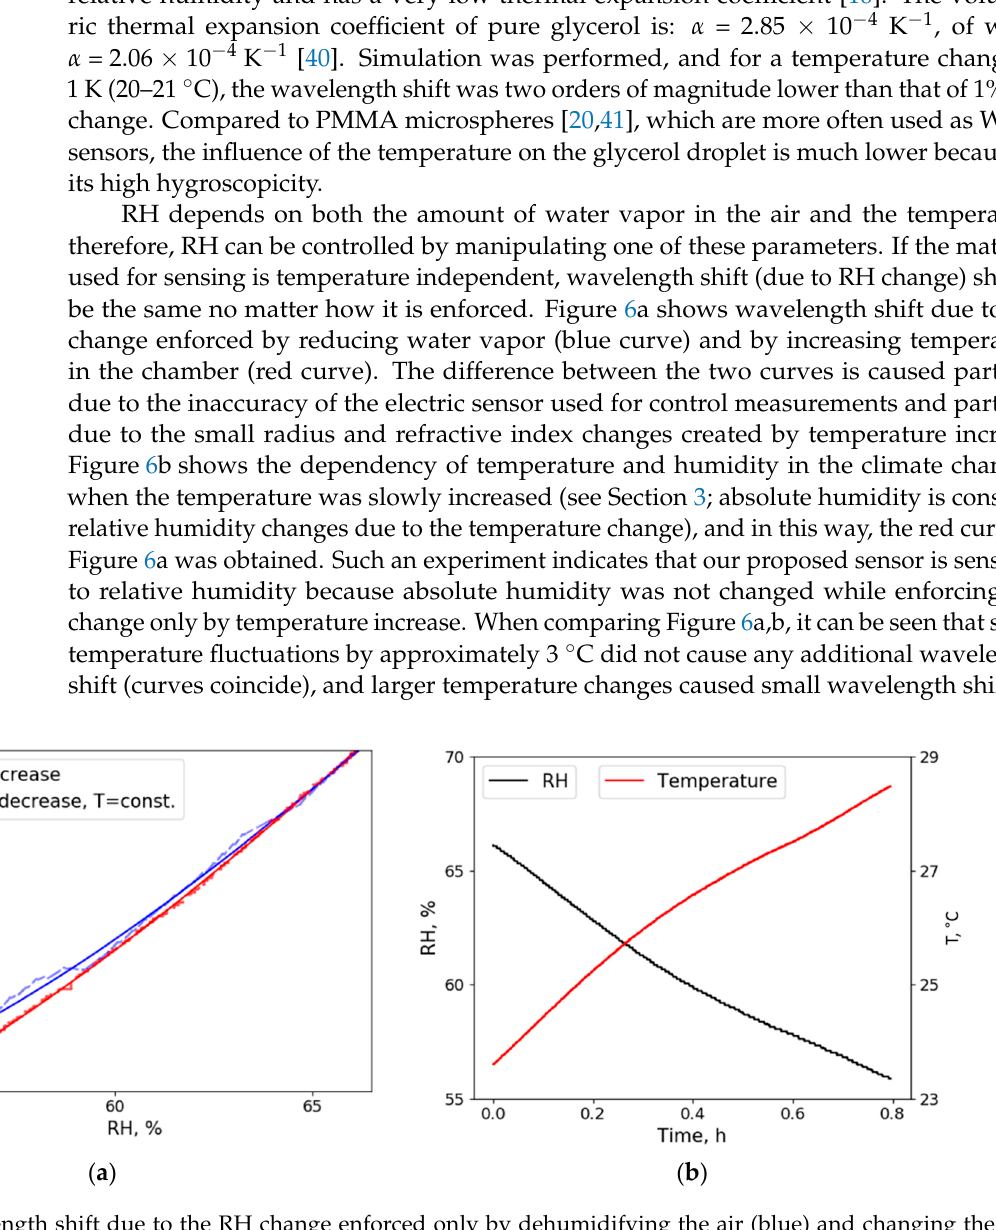
( b ) Figure 7. COMSOL simulations of whispering gallery modes in the glycerol droplet at 50% RH. Horizontal axis values represent the radius of the droplet. The dotted blue area on the right from the modes represents the surrounding environ- ment (air): ( a ) Fundamental mode; ( b ) Non-fundamental mode.